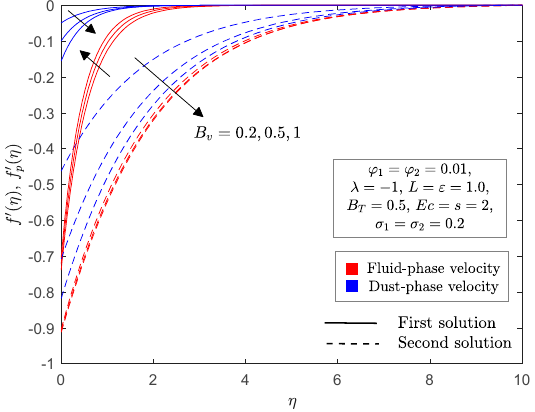
( ) ( ) , f f η η′′ for selected values of Figure 13. p ( ) ( ) Figure 13. f (cid:48) ( η ) , f p (cid:48) ( η ) for selected values of B v . , f f η η′′ for selected values of Figure 13. p